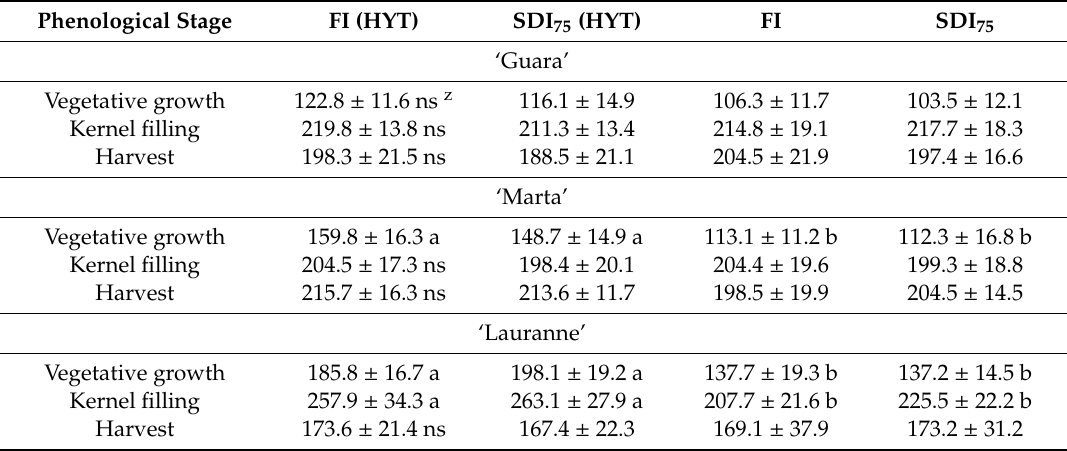
Table 4. Mean values of g s (mmol m − 2 s − 1 ) in each of the cultivars, irrigation and fertilization treatments during phenological